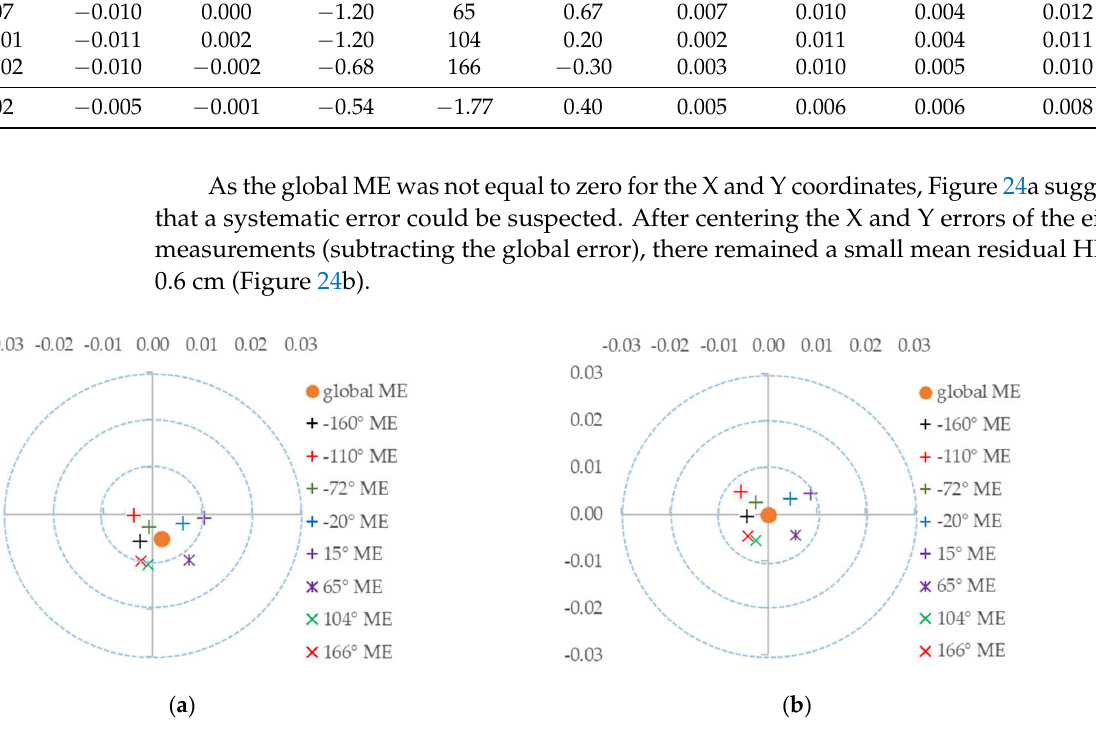
Table 7. The 12 photogrammetric reconstruction output parameters.